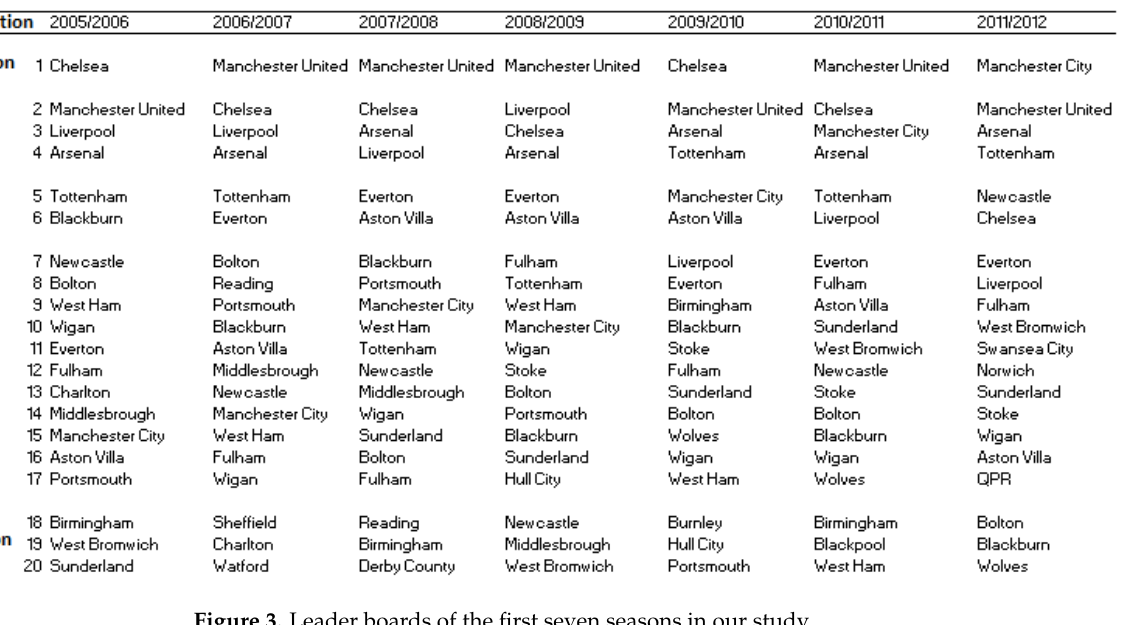
Figure 3. Leader boards of the first seven seasons in our study.